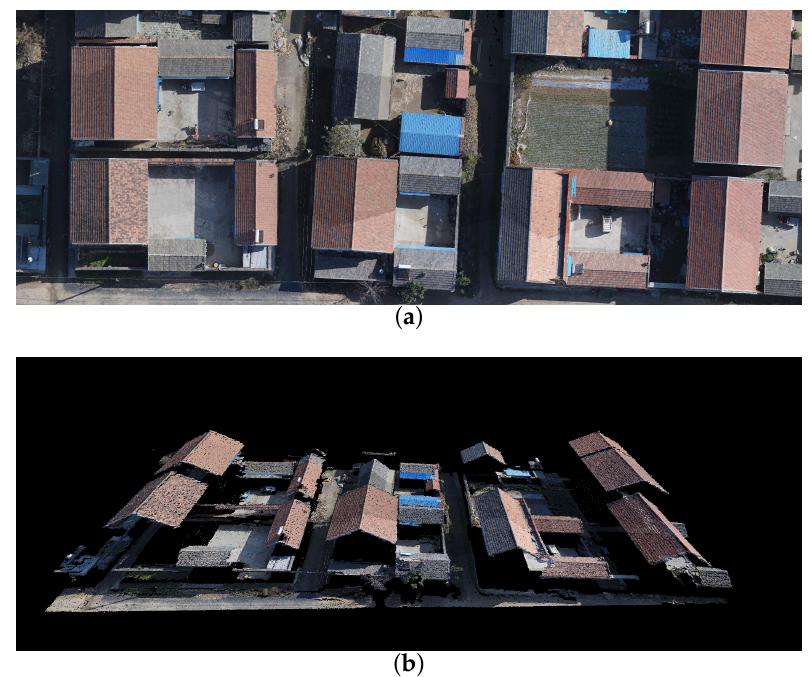
Figure 1. Digital orthophoto of a part of a village. ( a ) The digital orthophoto is the top view of some 3D points. ( b ) Looking at these 3D points from an oblique